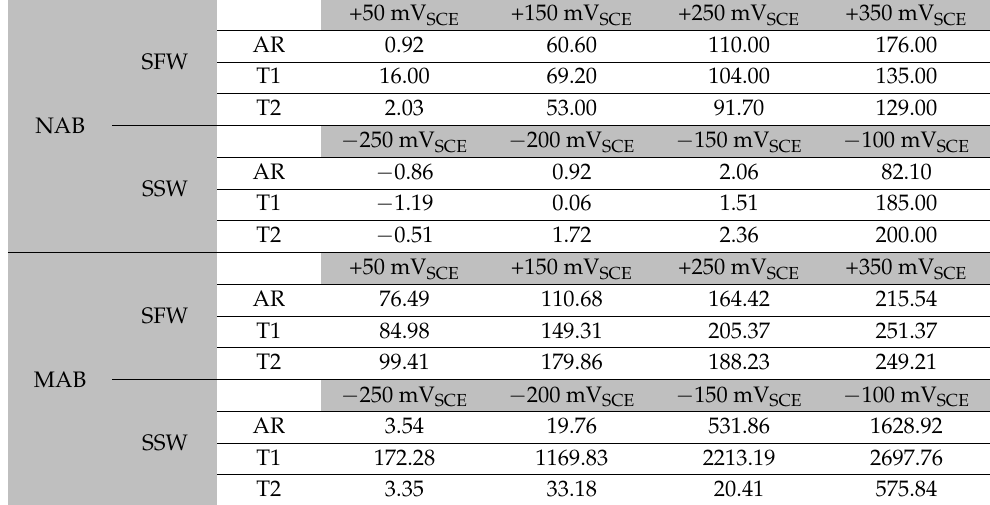
Table 5. Current density values ( µ A/cm 2 ) for NAB and MAB [21] with different thermal treatments and exposed to SFW and SSW at various potentials, after 72 h of corrosion